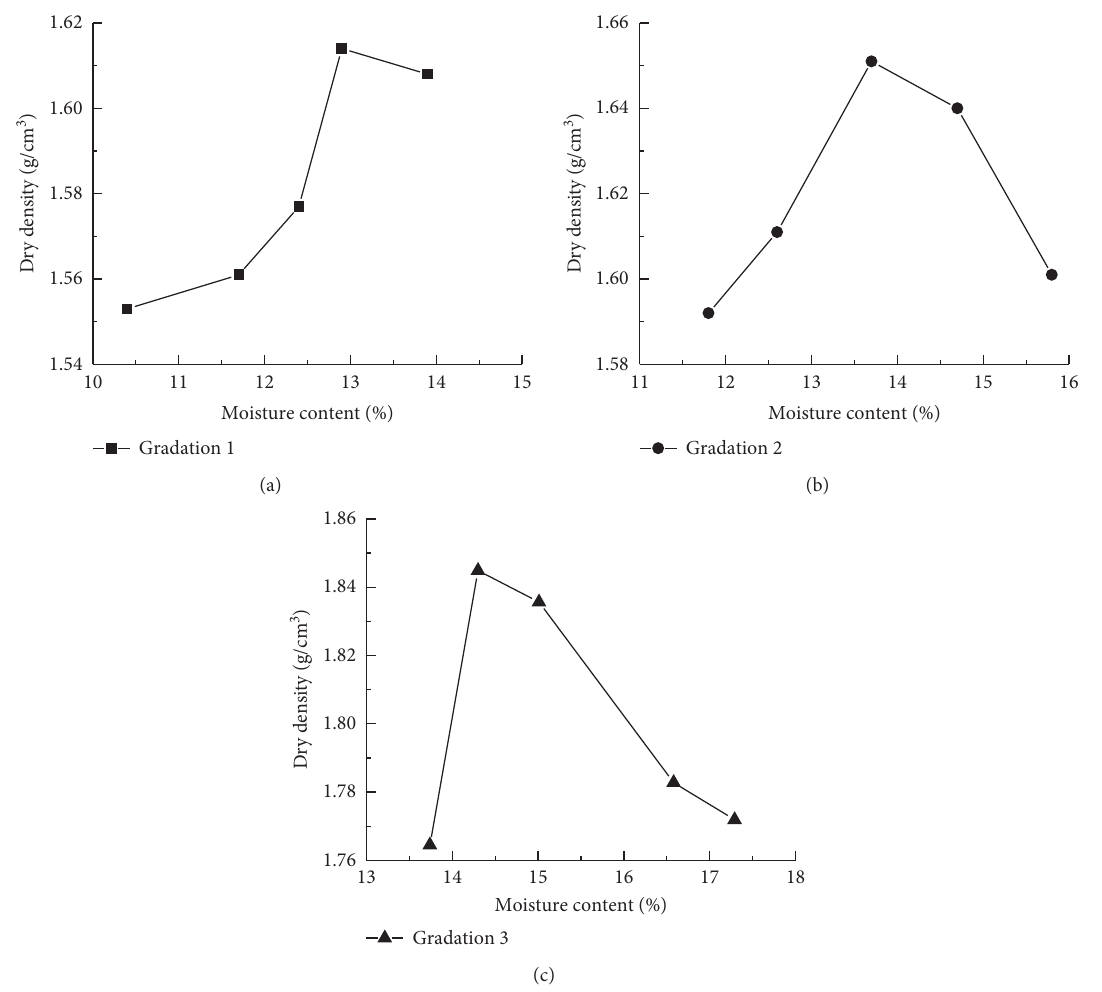
Figure 3: The relationship between dry density and moisture